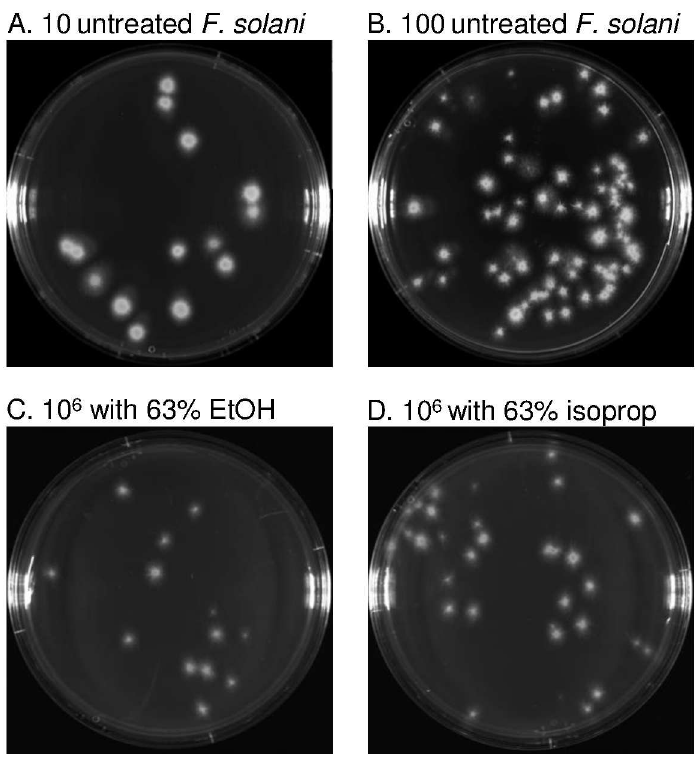
Fig 5. Treatment of F . solani conidia with ethanol and isopropanol markedlyinhibits colony formation on nutrient agar plates. Ten (A) or 100 (B) untreated F . solani conidiaform discrete colonieson nutrient agar plates that may be counted. When 10 6 conidiatreated for 30 sec with ethanol(C) or isopropanol(D), diluted, pelleted,washed, and then plated, nearly the same number of coloniesappearas when 10 untreated conidia are